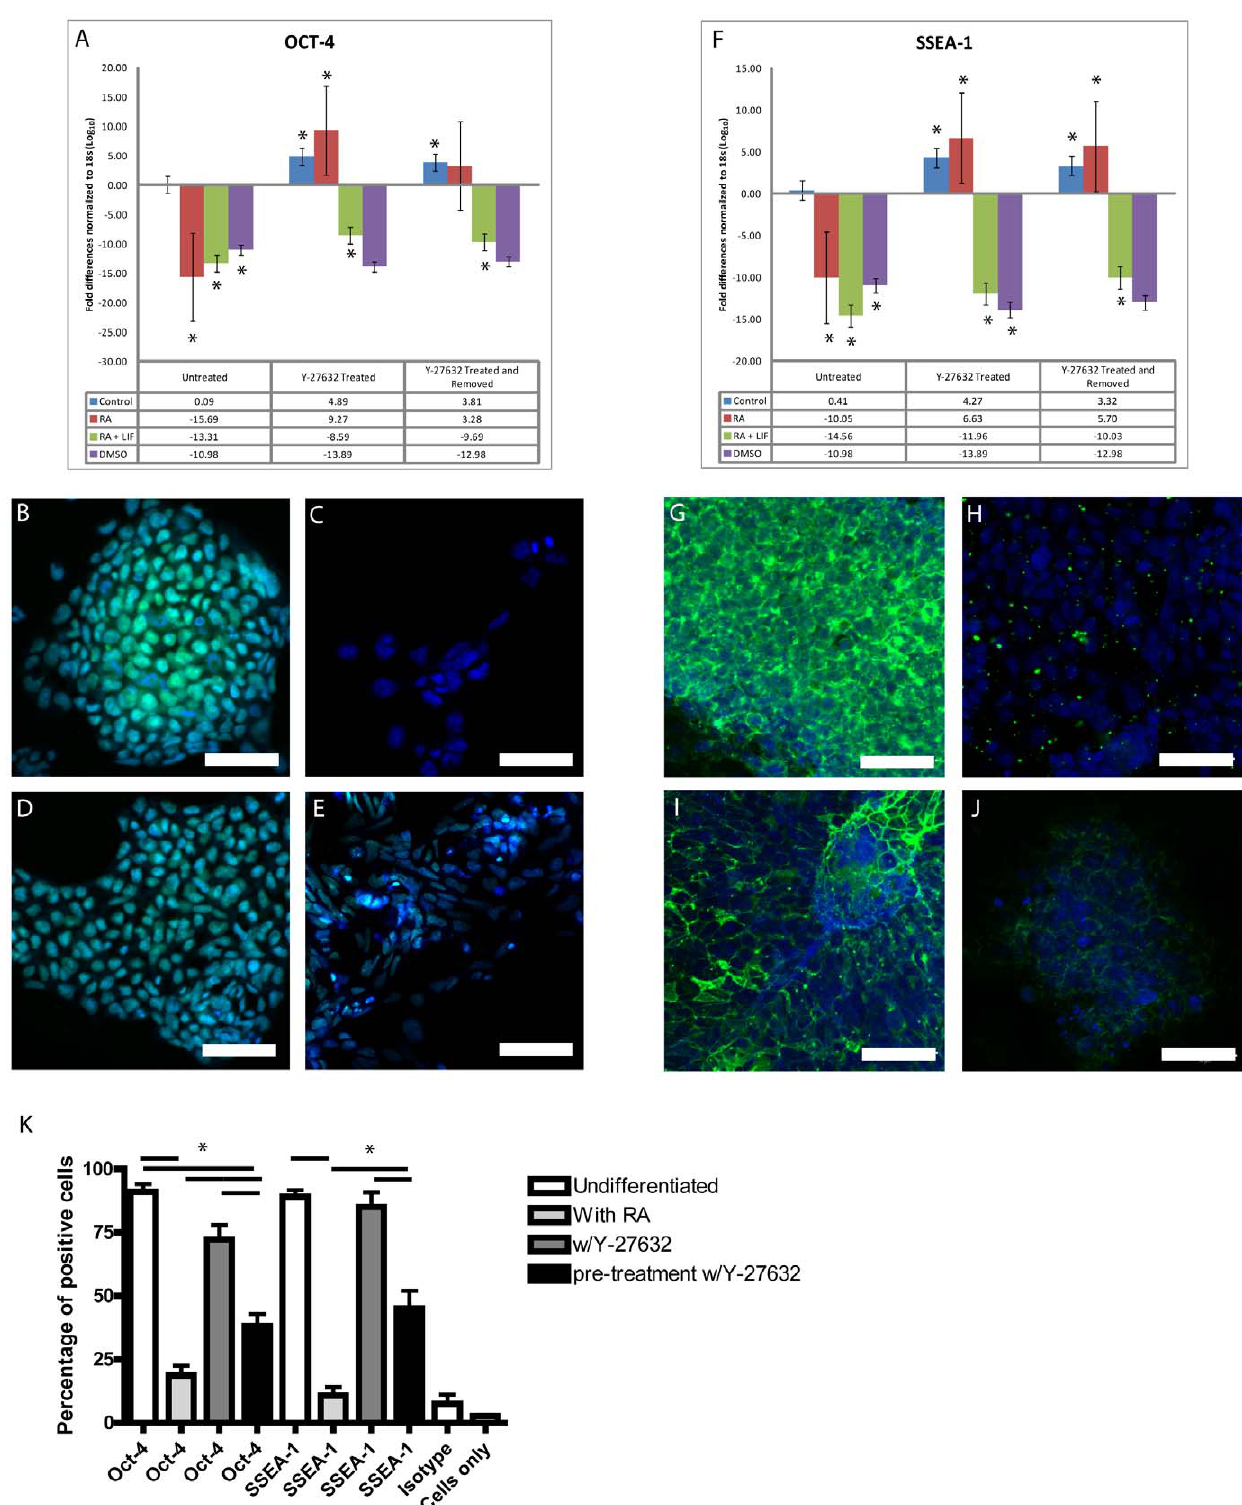
Figure 4. The decrease in endoderm differentiation observed in RA + Y-27632 treatment corresponds to maintenance of pluripotency. Total mRNA collected from samples was used in a qPCR with primers against the pluripotency marker Oct-4 (A). As expected, during directed differentiation into all three germ layers, the expression of Oct-4 is decreased. However, under RA + Y-27632 treatment (A) Oct-4 levels are more similar to that in undifferentiated cells. Immunofluorescent detection of Oct-4 in undifferentiated cells (B) and in cells treated with RA (C) RA plus Y-27632 (D) or RA with Y-27632 pre-treatment (E). qPCR with SSEA-1 probes showed similar levels and trends to that of Oct-4, with significant decreases observed during differentiation into any lineage (F). Furthermore, as with Oct-4 SSEA-1 mRNA expression remained at control levels during